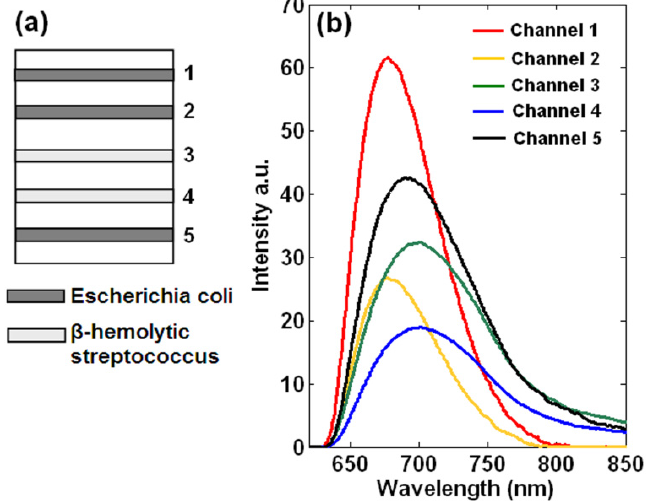
(a) Different kinds of DNA probes immobilized on the substrate corresponding to different channels. (b) Setup response to samples with different oligonucleotides and fluorescent labels.